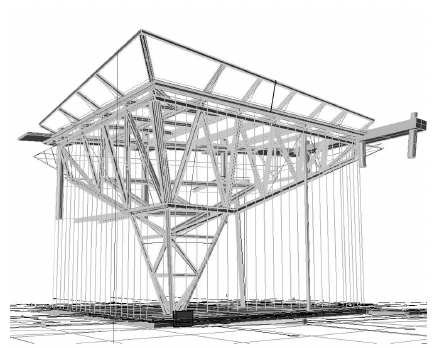
Figure 7: 3D view of steel – concrete structure with aramide cables